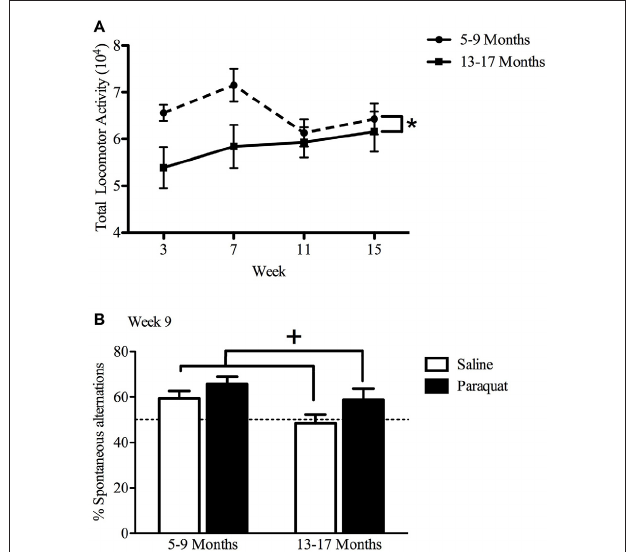
FIGURE 6 | Effect of long-term (low dose) paraquat exposure and age on locomotor activity and spontaneous alternation version of a Y-maze. Irrespective of paraquat treatment, the older cohort of mice (13–17 months) showed reduced total home-cage locomotor activity (A) in comparison to the younger cohort (5–9 months). ∗ p < 0.05 relative to the younger cohort (5–9 months; data presented collapsed over paraquat treatment for better representation). In the absence of a significant age effect, paraquat treatment increased the number of spontaneous alternations in a Y-maze (B) . Yet, although not significant, the magnitude of this effect appears greater in the aged mice. Dotted line indicates chance performance. + p < 0.05 relative to saline treated mice (collapsed over